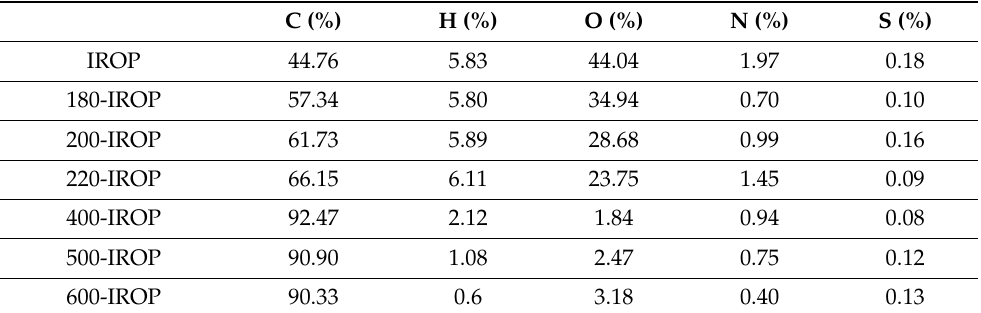
Table 1. Ultimate analysis (db.%) of the IROP and its derived hydrochars and biochars at different carbonization